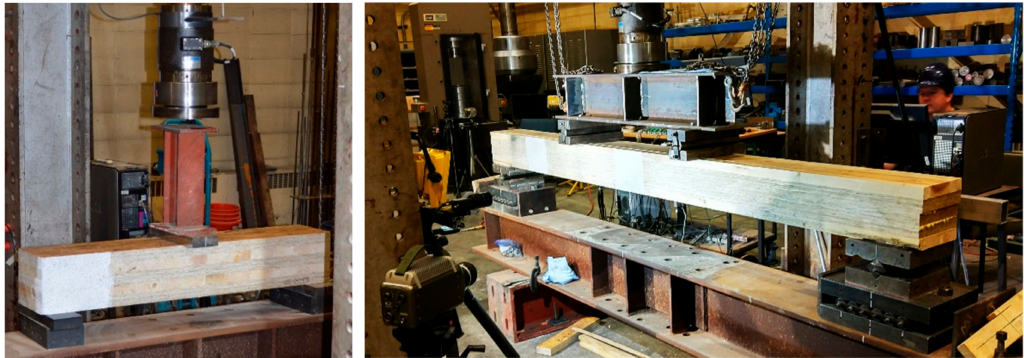
Figure 4. Short-span shear test setup ( left ) and third-point bending test setup ( right